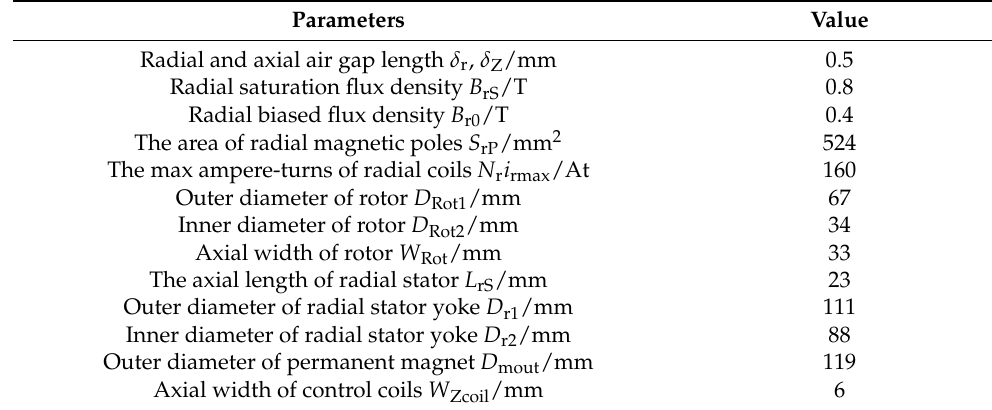
Figure 4. The structure parameters of six-pole RAHMB. Table 1. Parameters of radial stator.